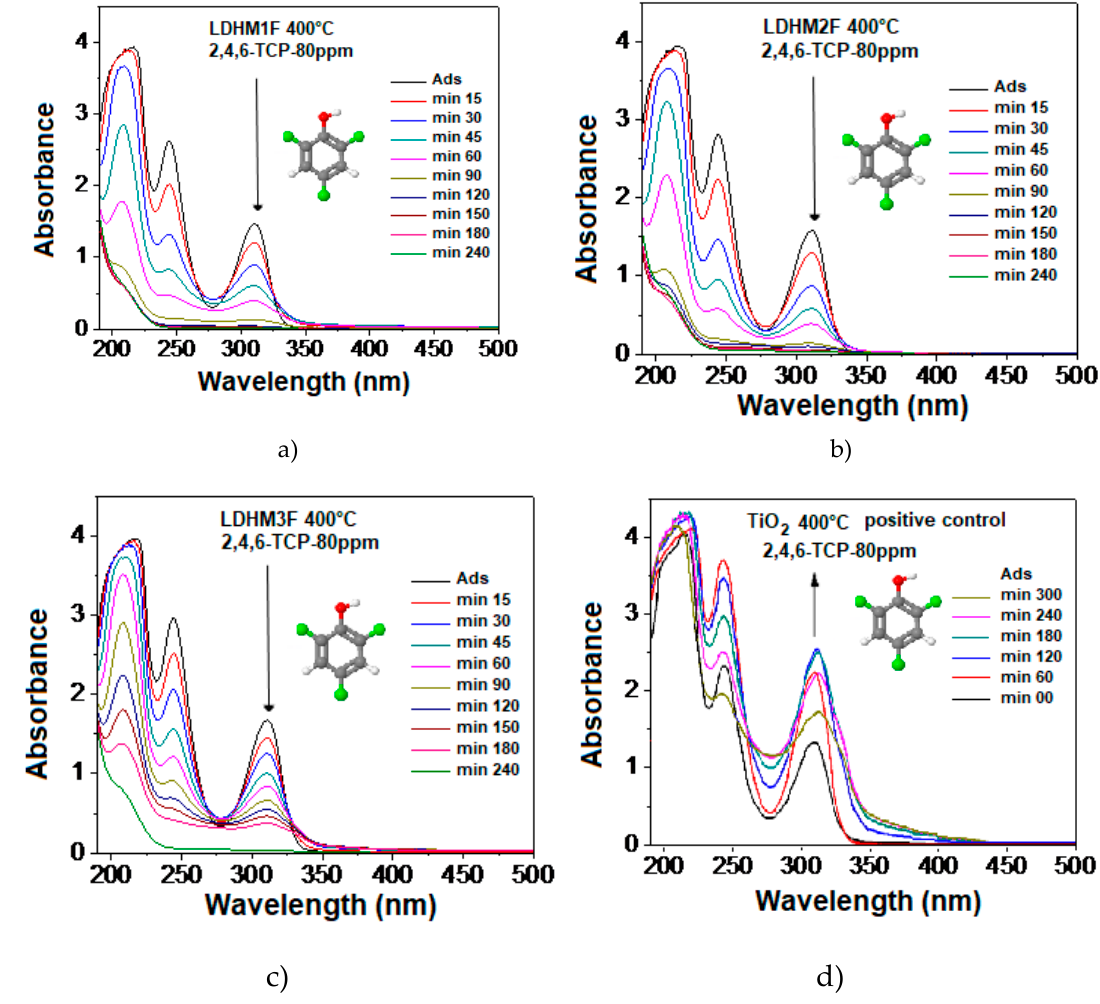
Figure 8. UV-vis spectra of the photocatalytic degradation of 2,4,6-TCP using Activated Lamellar Double Hydroxides a ) LDHM1F-400 °C, b ) LDHM2F-400 °C, c ) LDHM3F-400 °C, and d ) TiO 2 positive control.